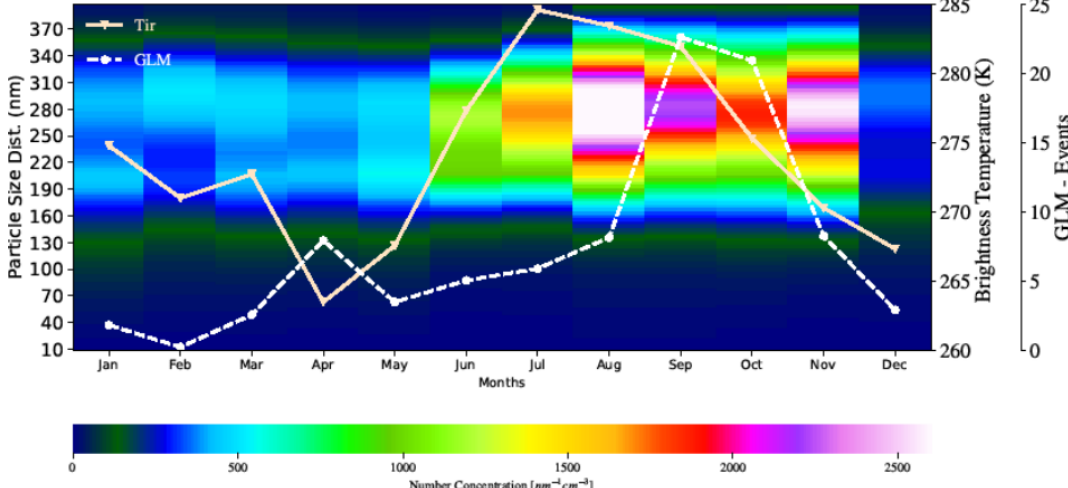
Figure 2. Seasonality of particle size distributions at ATTO (60m sampling height), brightness temperature ( T IR ) and lightning density (number of lightnings per 5min time bins in area of 50 × 50km 2 around ATTO). All values are shown as monthly means. Average time frame for all parameters ranges from October 2018 to September 2020.